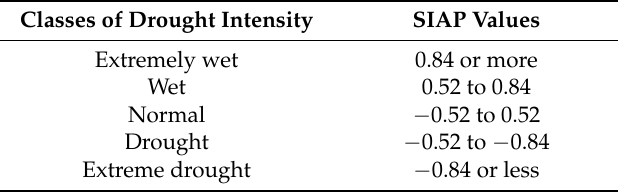
Table 1. Classification of Standard Index of Annual Precipitation (SIAP) values.